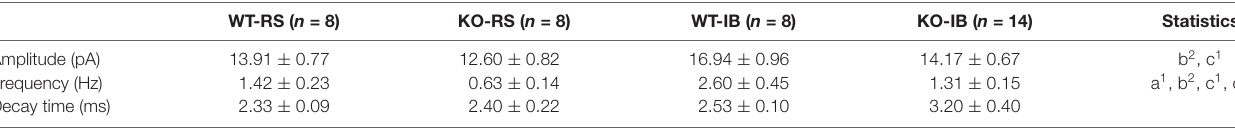
TABLE 3 | mEPSC amplitude, frequency, and decay time of layer 5 pyramidal